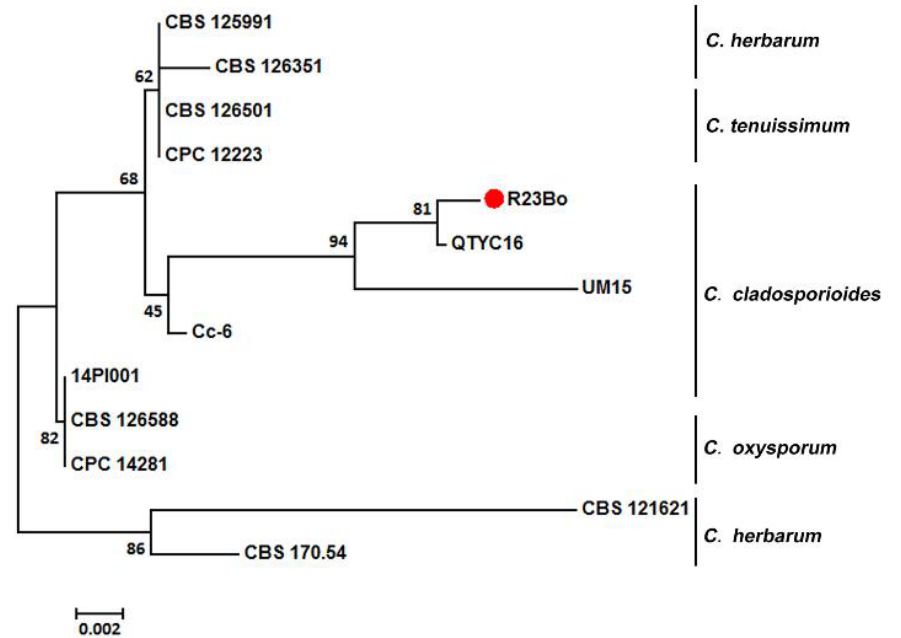
Figure 4. A neighbor-joining (NJ) tree constructed for 13 isolates of 5 Cladosporium species using software MEGA7. The Puccinia striiformis hyperparasitic isolate (R23Bo) of C. cladosporioides is marked with a red dot. The values are the frequencies in percentage for the branches with 1000 bootstrap replications.